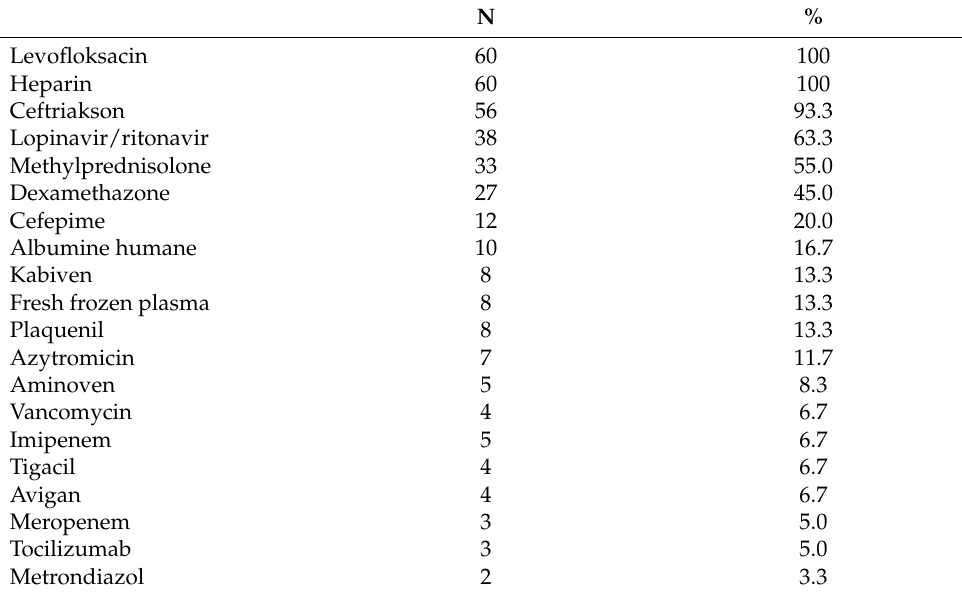
Figure 1. Comparison between survived and dead. Patients’ medication during their hospitalization is shown in Table 4. The most com- mon pharmaceutical interventions in patients were levofloxacin (100%), heparin (100%), ceftriaxone (93.3%), lopinavir/ritonavir (63.3%), and methylprednisolone (50%). Descriptive statistics for the patients’ diagnostic tests are shown in Table 5. The mean value for ferritin was 2101 ng/mL; for lactate dehydrogenase (LDH), 738 U/L; for creatine kinase CK, 857 U/L; for fibrinogen, 578 mg/dL; for PCR-I, 169 mg/dL; and for D-dimer, 5748 mg/mL. Table 4. Patients’ medication during their